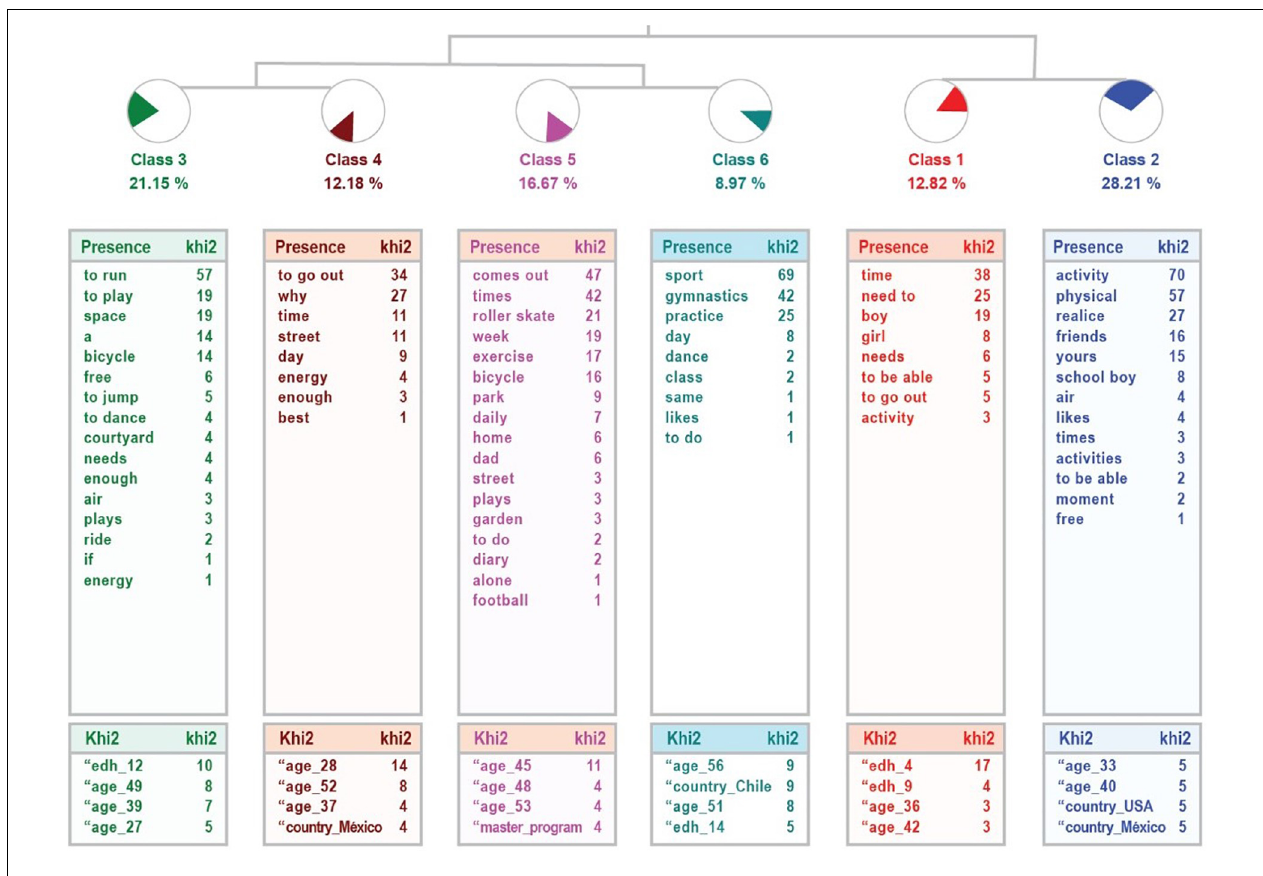
FIGURE 2 | Dendrogram of responses given by parents in the community sample. TABLE 11 | Information from the analysis to the question “Is the physical activity developed sufficiently or insufficiently?” Community sample. Class ECU %